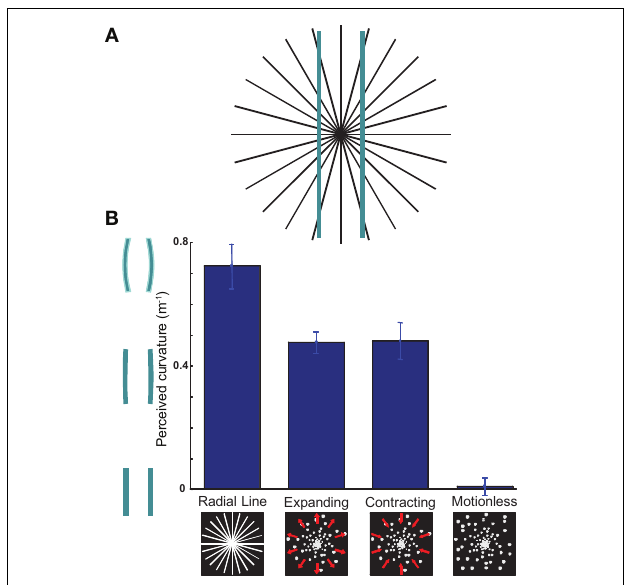
FIGURE 1 | The Hering illusion can be induced by expanding or contracting dot motion. (A) Illustration of the Hering illusion: the straight bars appear bent. (B) The bars bend in the same direction whether presented against a background of radial-lines, expanding optic flow, or contracting optic flow. Against a background of motionless dots, illusory bending disappears. Ordinate values show the negative of the curvature required to nullify the illusion. n = 13, error bars